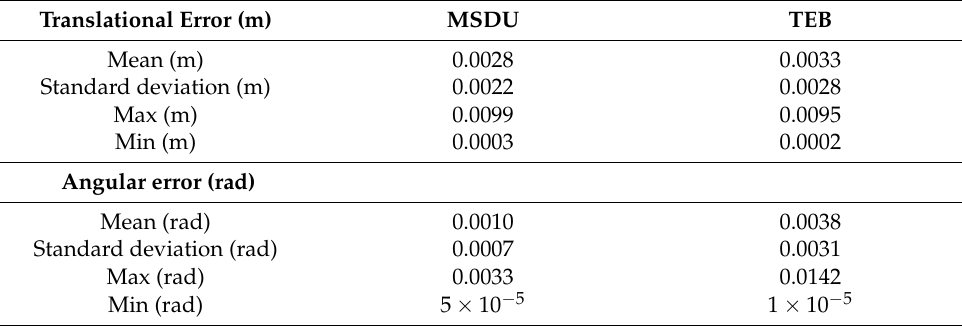
Figure 11. Distance between final robot pose and desired goal position for the MSDU Local Planner (black) and the TEB Local Planner (white) over short (<1 m) paths. ( a ) Translational error between the final robot pose and the desired goal position; ( b ) angular error between the final robot pose and the desired goal position. Table 5. Summary of performance of MSDU and TEB for short paths (<1